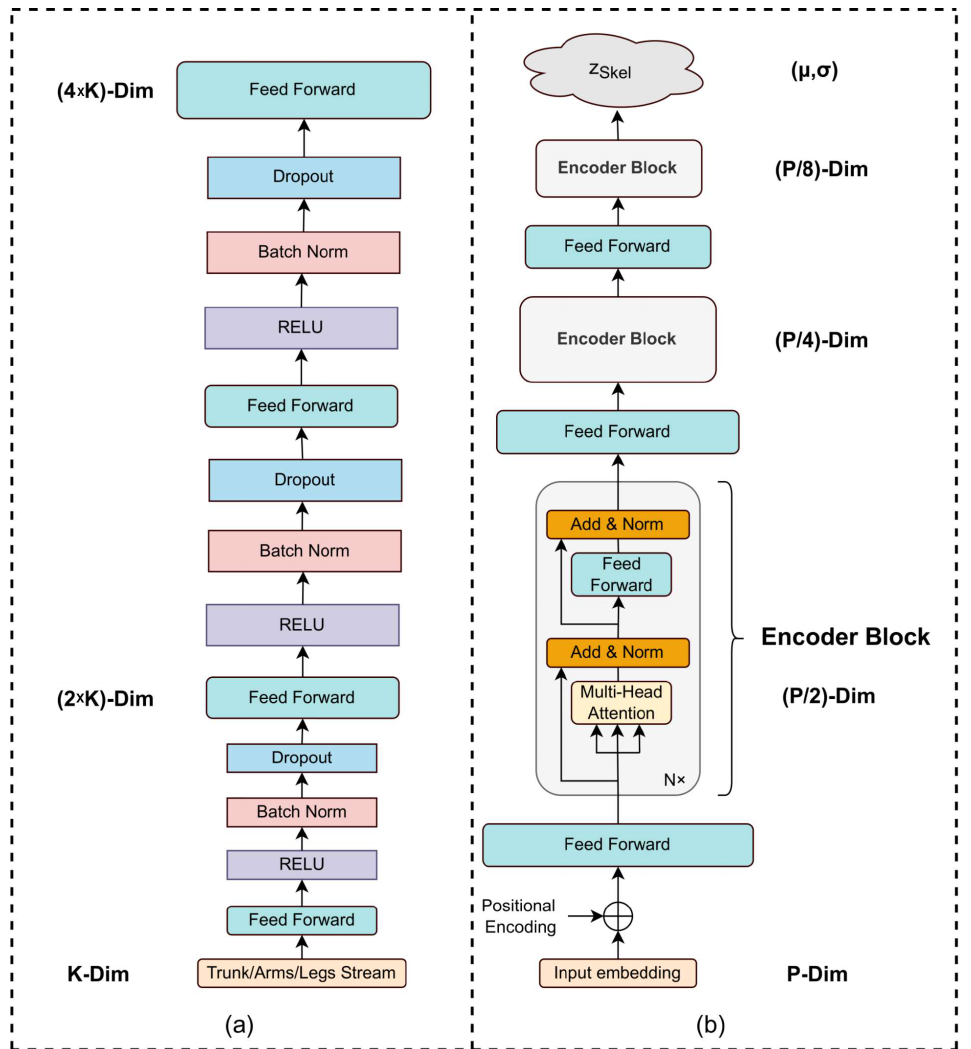
Figure 2. An overview of ( a ) the multi-stream encoder E MS and ( b ) the multi-layer Transformer encoder E T . The multi-stream encoder E MS performs feature vector upsampling to each input stream of dimensionality K with the purpose to model the joint local relationships. The Transformer encoder E T performs self-attention through three encoder blocks and dimensionality reduction using linear projections. The final output is a pair of vectors ( µ , σ ) that composes the skeletal latent distribution. Each encoder block has N layers and H attention heads. P denotes the dimension of the concatenated input skeletal feature